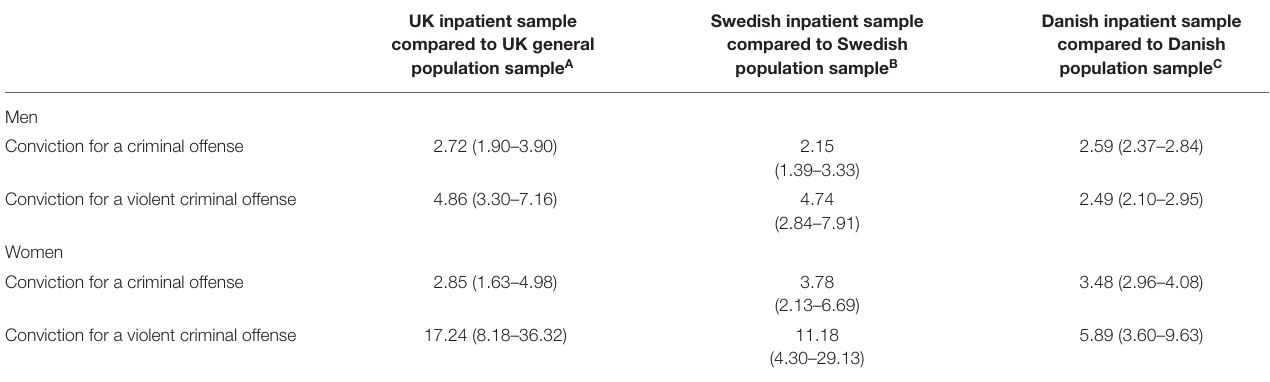
TABLE 1 | Odds ratios for criminal convictions up to age 30 comparing inpatient samples with severe mental illness to general population samples from three